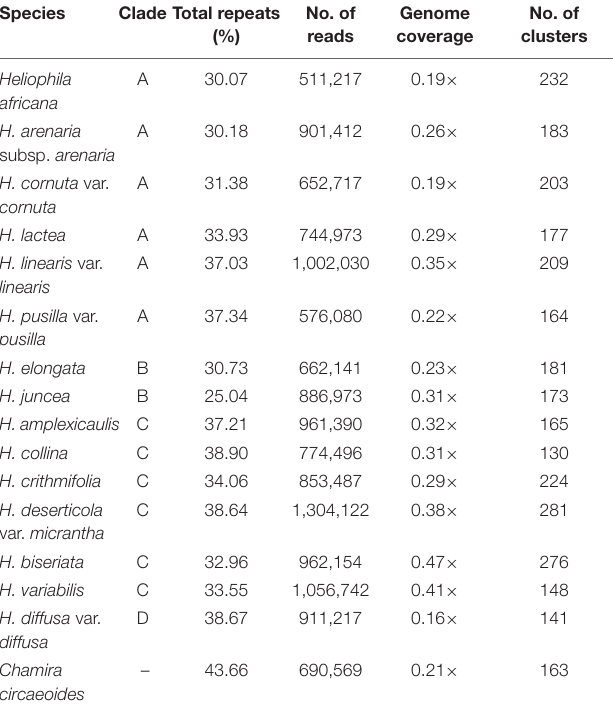
TABLE 1 | Characteristics of NGS data used for repeatome analysis. Species Clade Total repeats